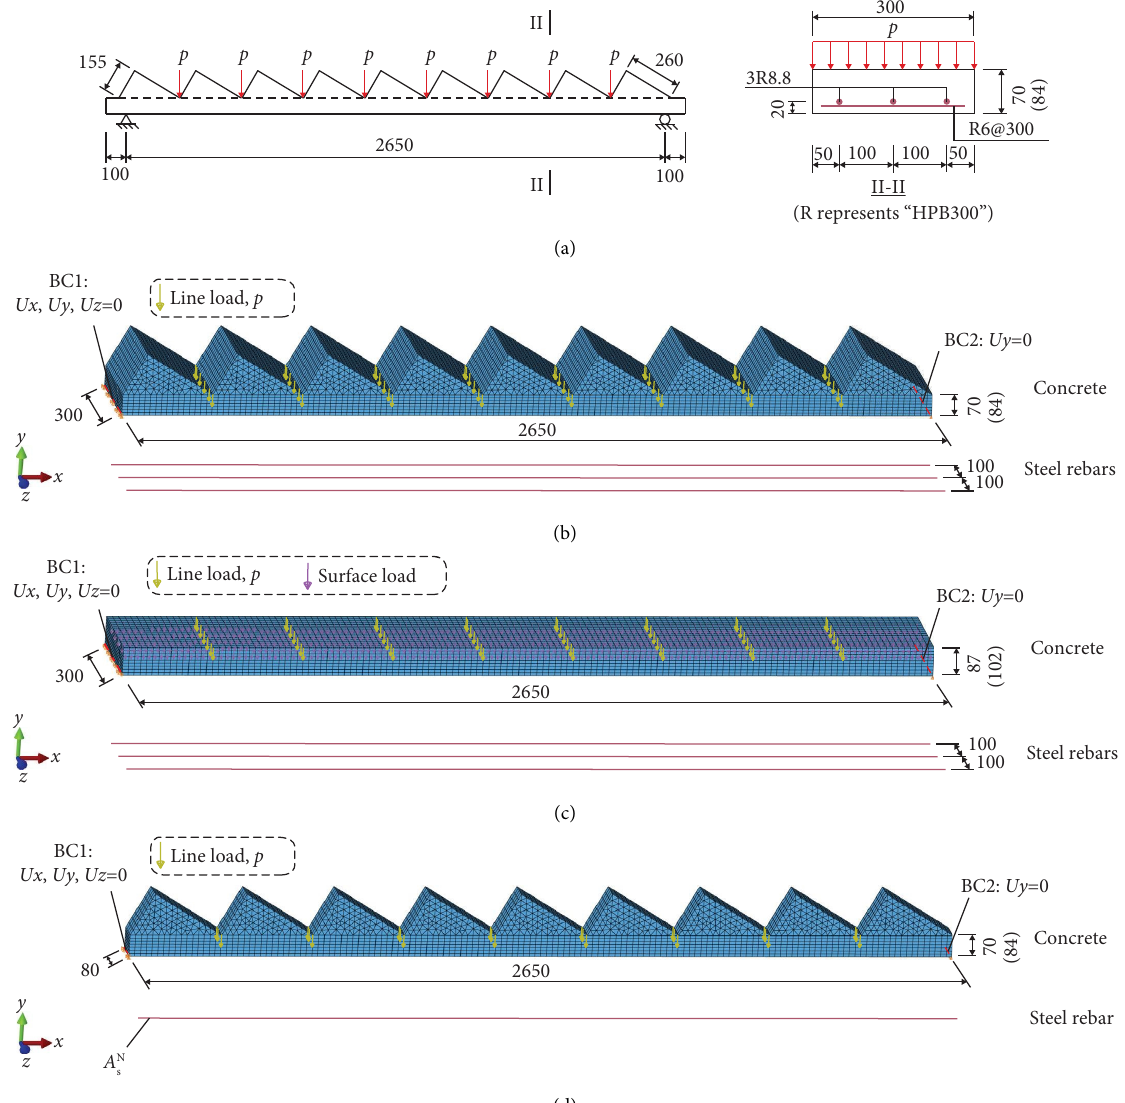
Figure 4: Te confguration of the RC stair slabs in the experiment [4] and solid FE models including meshing, loads, and boundary conditions (unit: mm). (a) Geometry and reinforcement of the stair slabs in the experiment [4]. (b) Stair slab models. (c) Equivalent fat slab models. (d) Normalized